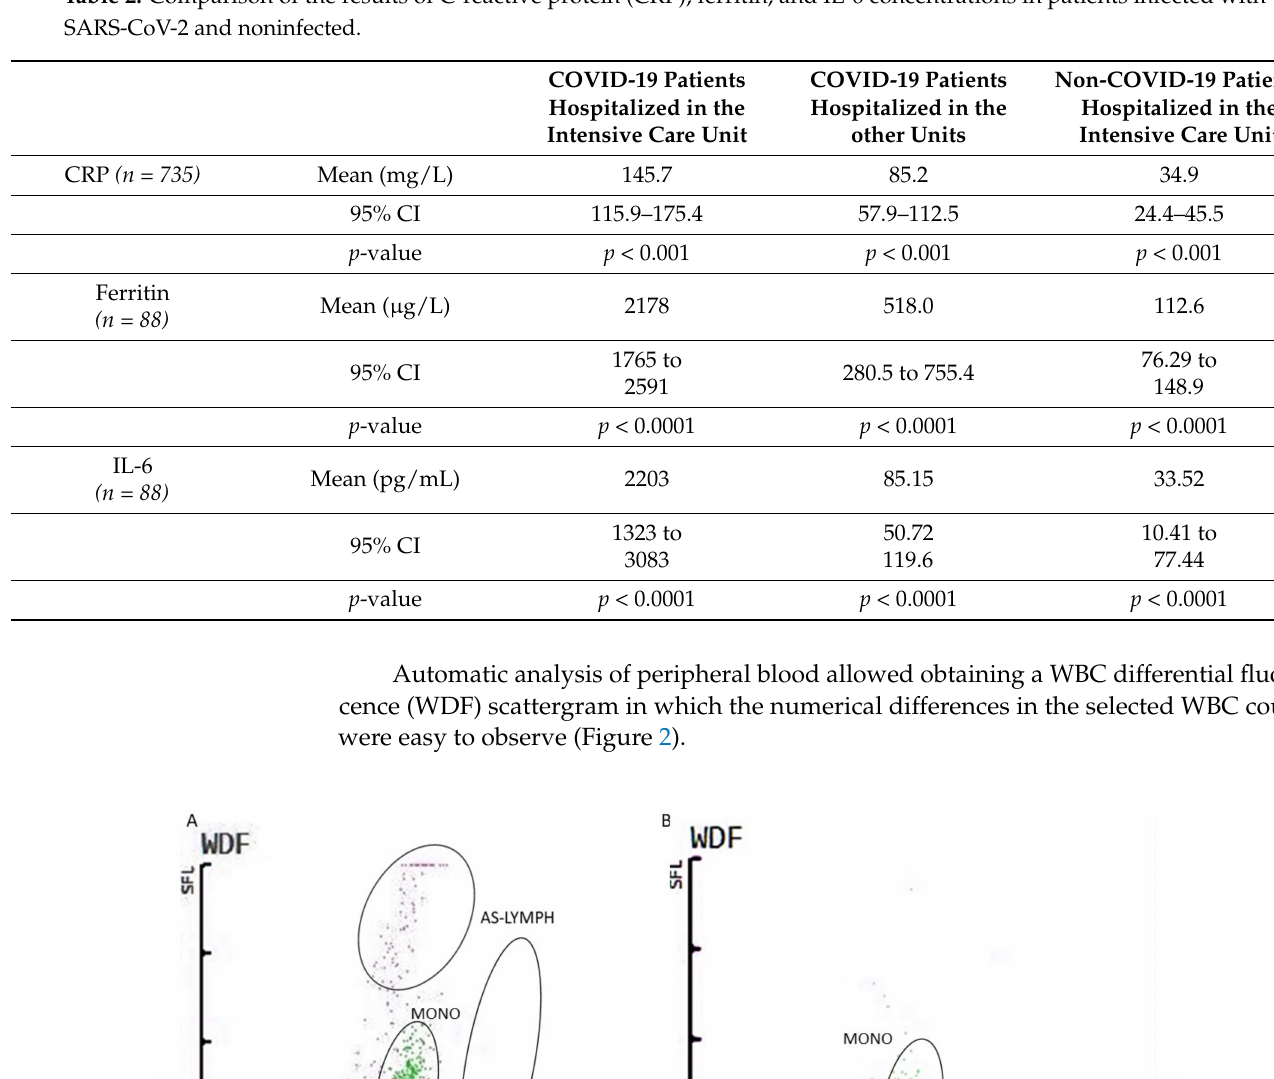
Table 2. Comparison of the results of C-reactive protein (CRP), ferritin, and IL-6 concentrations in patients infected with SARS-CoV-2 and noninfected.